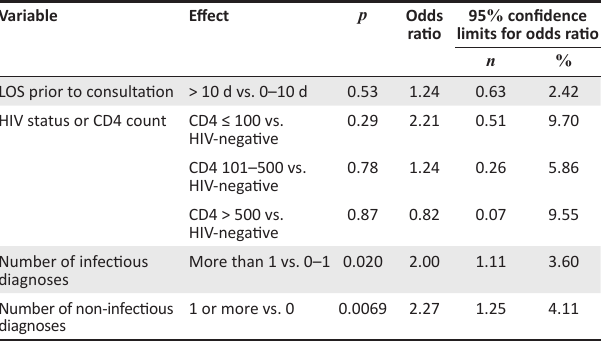
FIGURE 2: Number of infectious diagnoses (excluding human immunodeficiency virus) made in individual patients seen by infectious diseases department at